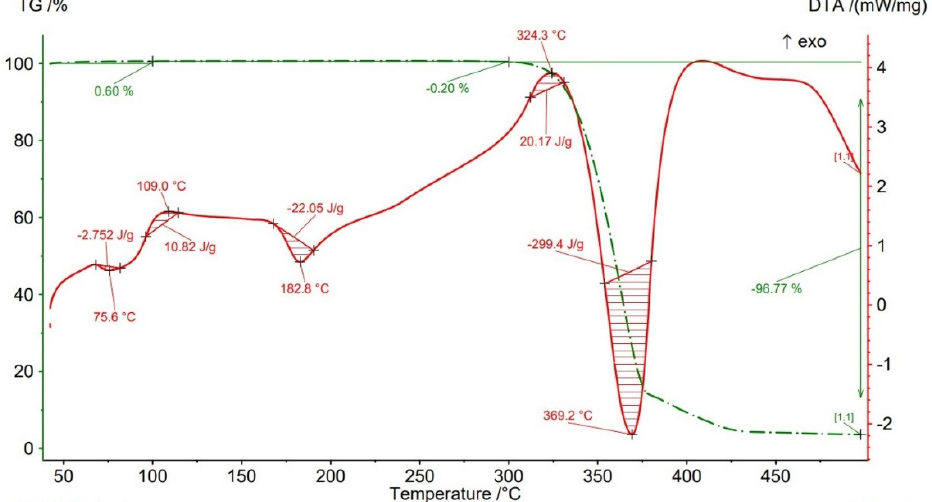
Figure 14. TGA results for sample with 50% infill density.